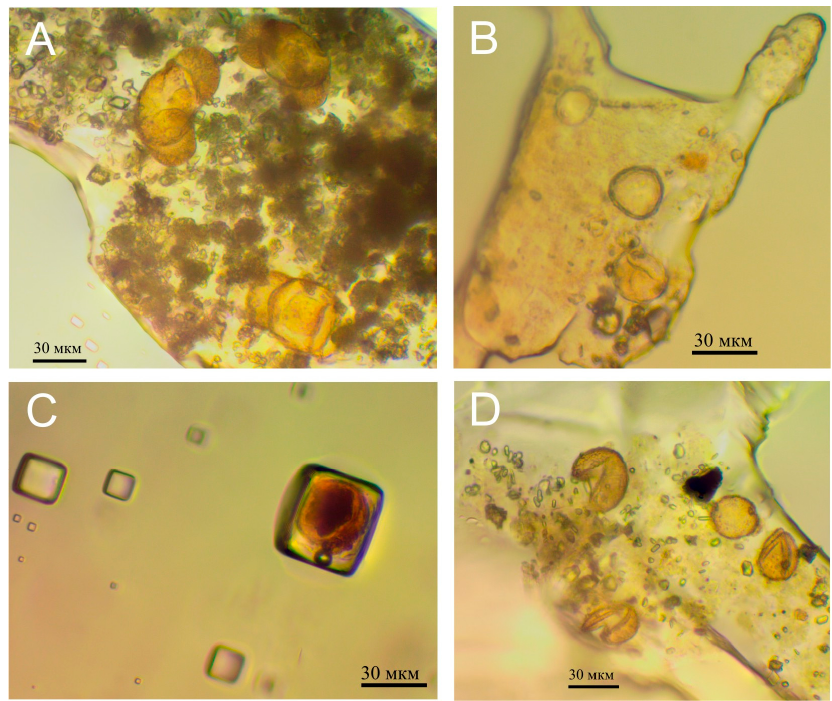
Figure 4. ( A – D ) Well-preserved micro-phytoplankton, numerous spores, and pollen of terrestrial plants in primary and secondary fluid inclusions in the halite of sample No. 11 (well TG 6, depth 618.4 m).